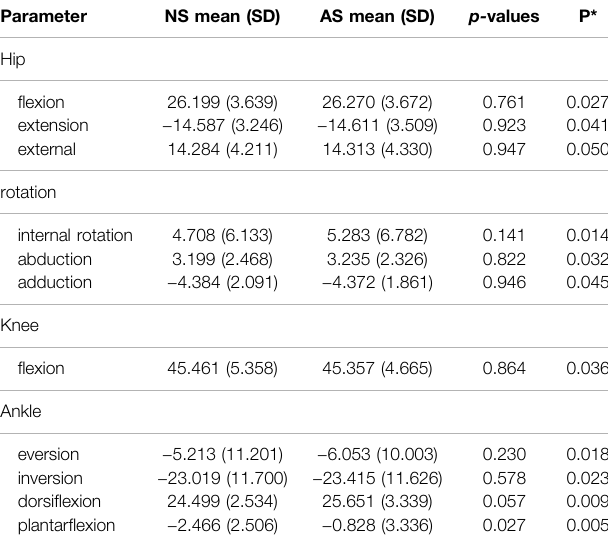
TABLE 1 | Peak angles of lower limb joints for NS and AS during stance ( °